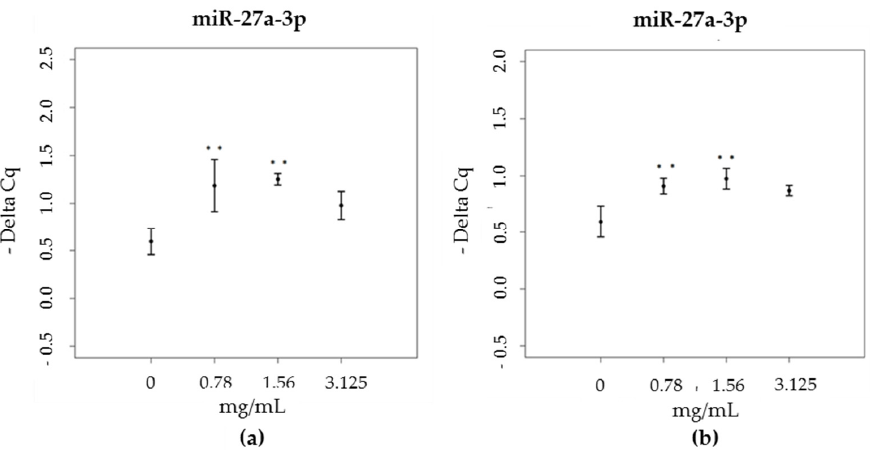
Figure 5. miR ‐ 27a ‐ 3p expression levels ( ‐ Delta Cq) in HaCat cells, treated with increasing concentrations of ( a ) green propolis extract (0.78–3.125 mg/mL) and ( b ) brown propolis extract (0.78–3.125 mg/mL).